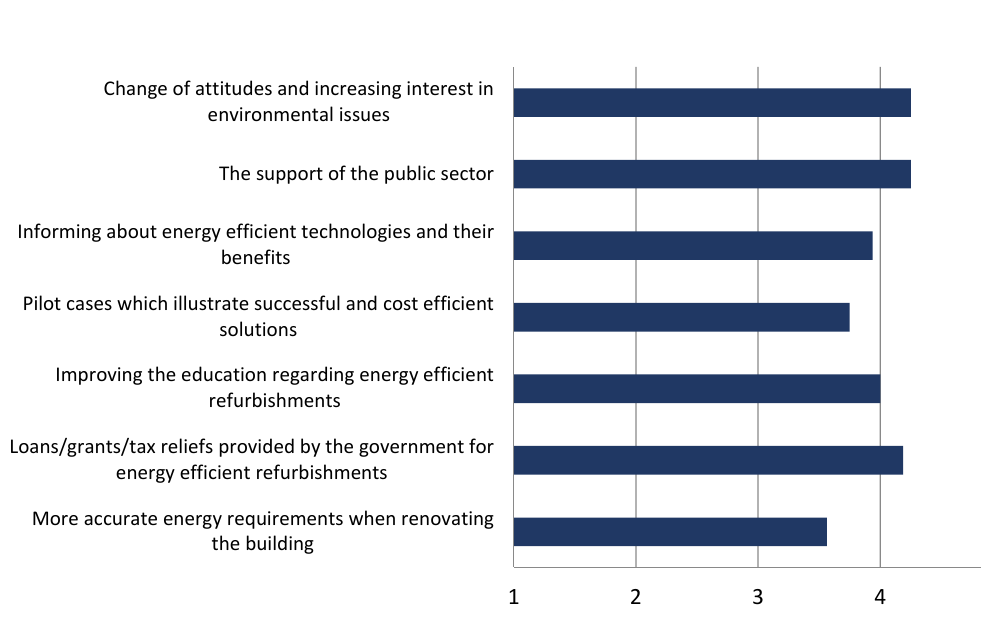
Figure 6. Most potential solutions for speeding up energy efficient renovations in Russia.